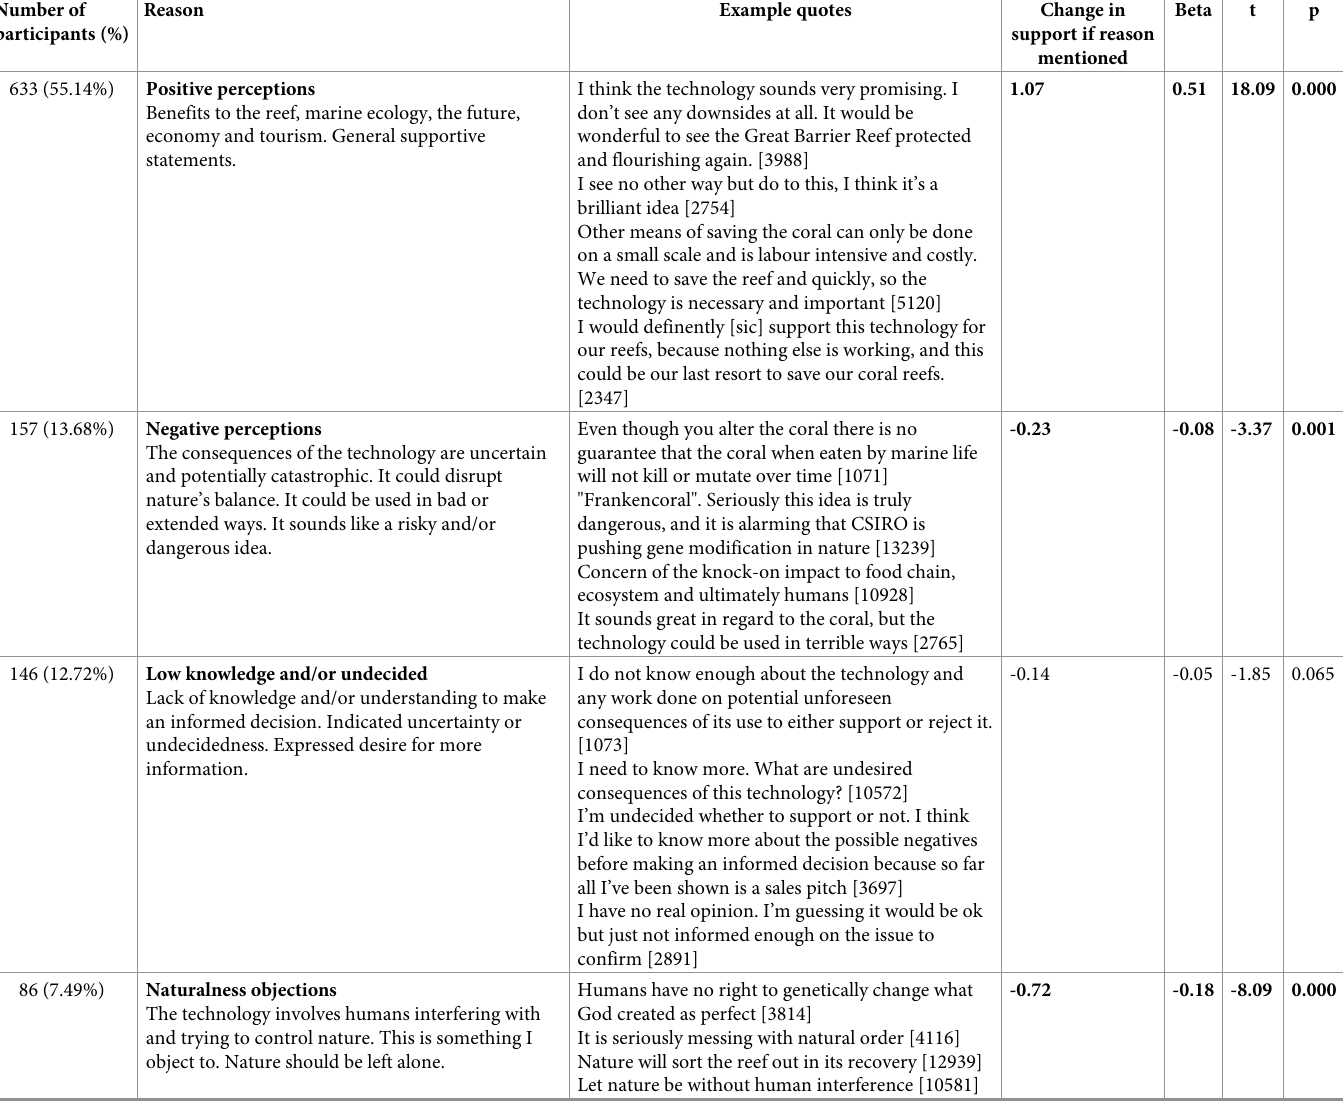
Table 1. Common themes to explain one’s support for the development of the technology. Number of participants (%)